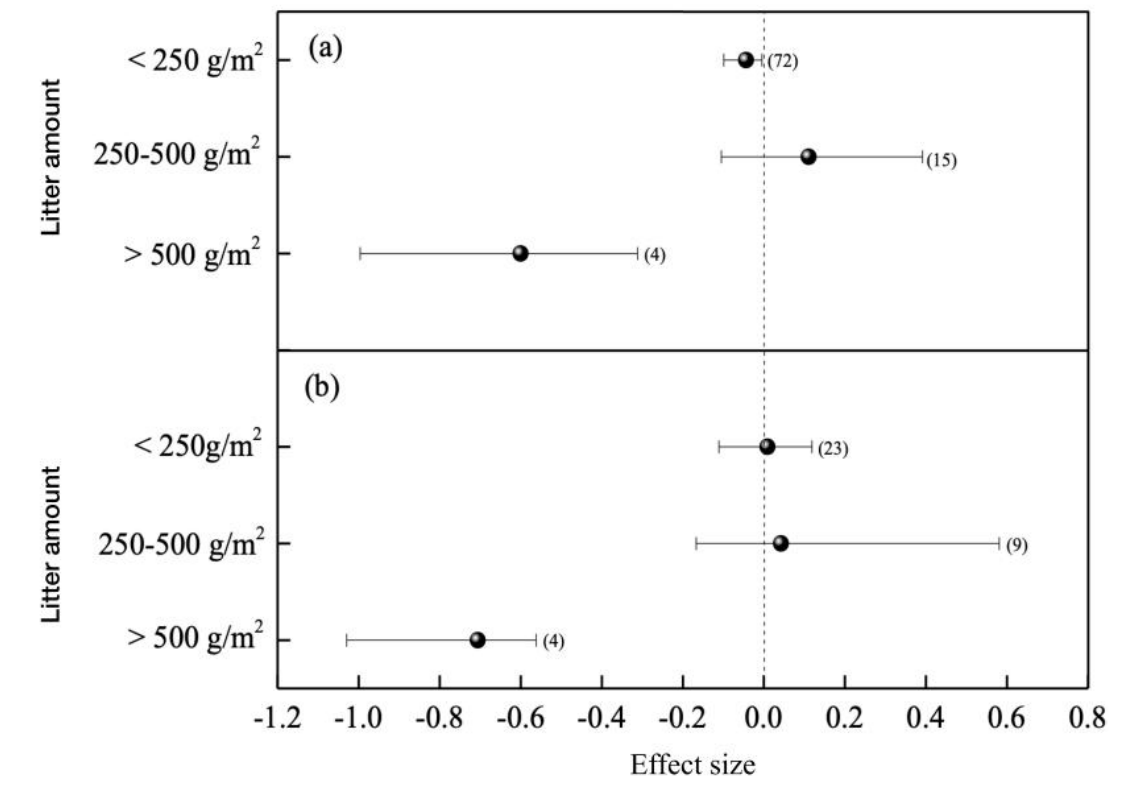
Figure 5. Mean effect size for seedling emergence under different litter amounts cover of broadleaf ( a ) and needle ( b ) litter. Error bars represent 95% CIs. The numbers in brackets represent the sample size of each indicator.